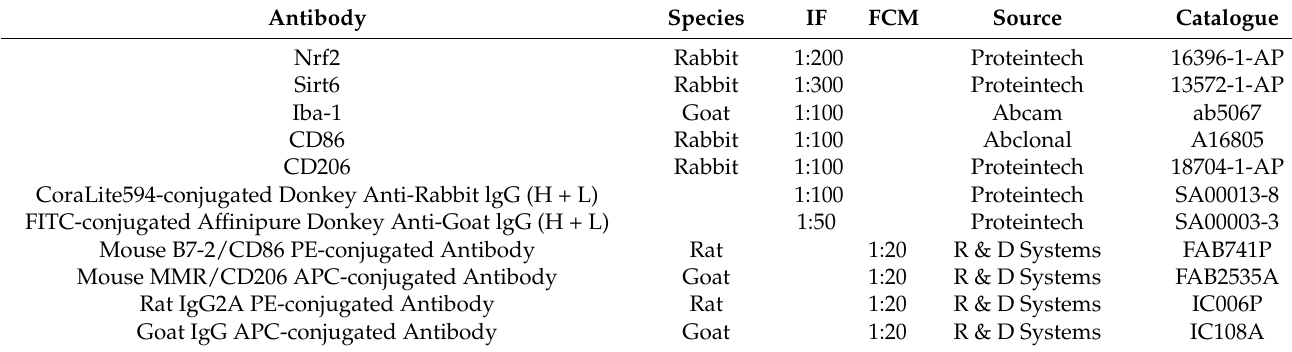
Table 1. All primary and secondary antibodies used in this